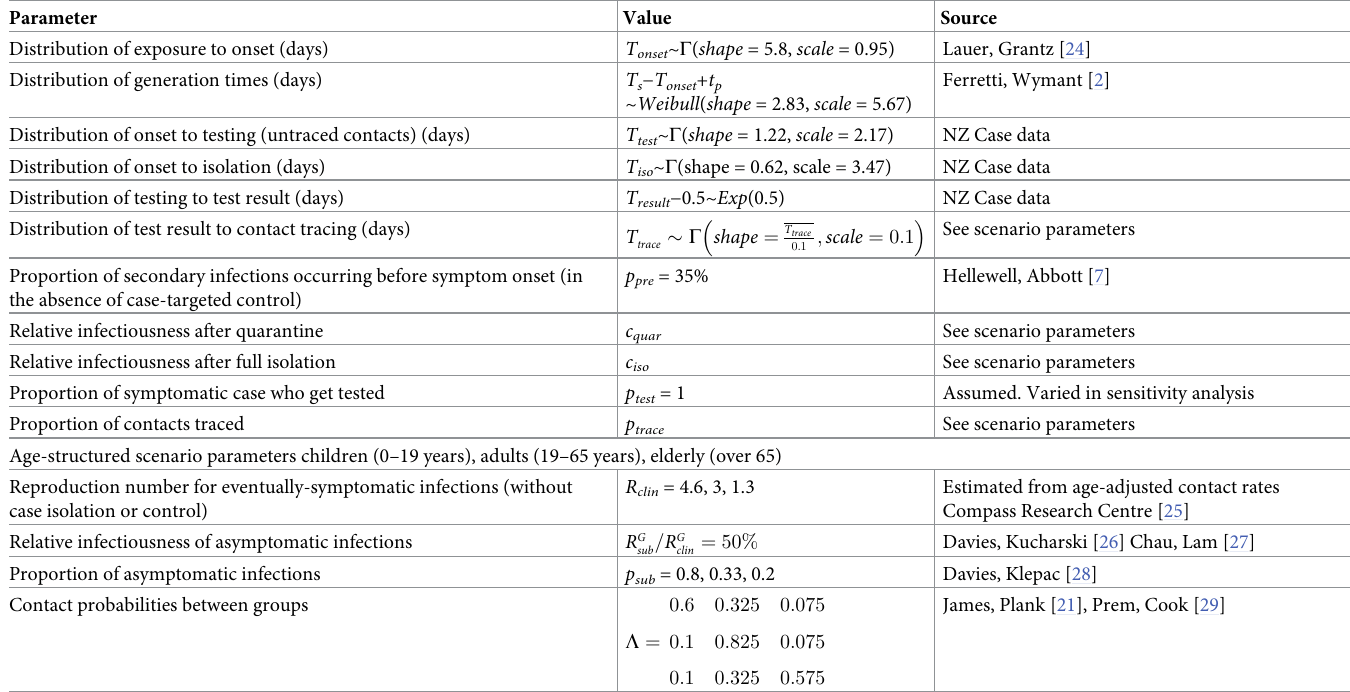
Table 1. The parameters used in the model and their